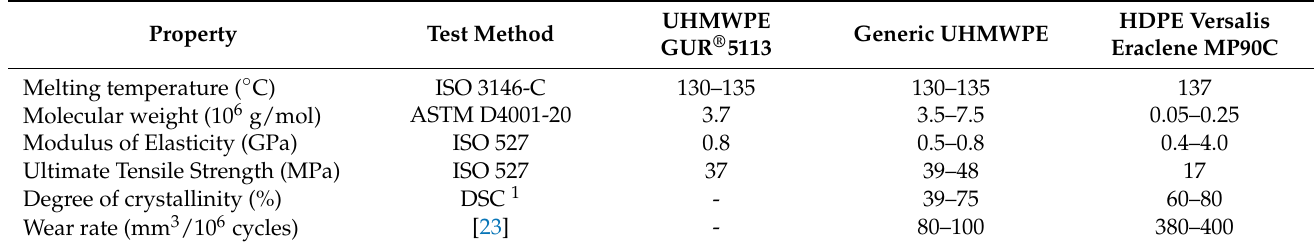
Table 2. Comparison of main materials’ properties.